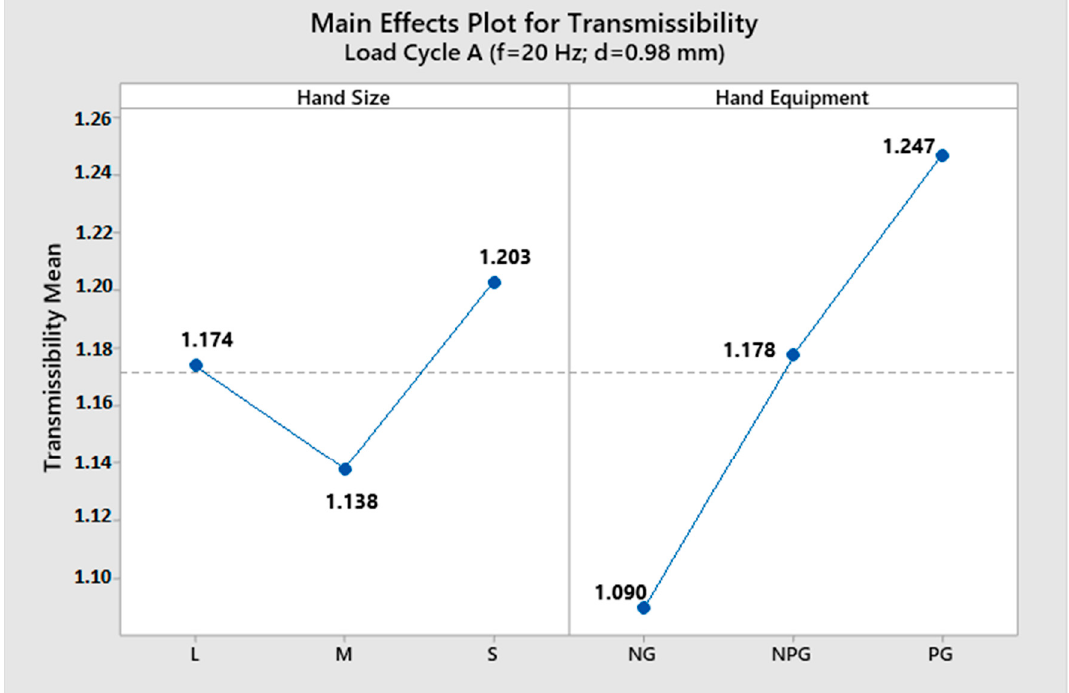
Figure 3. Main effects plot for transmissibility for load cycle